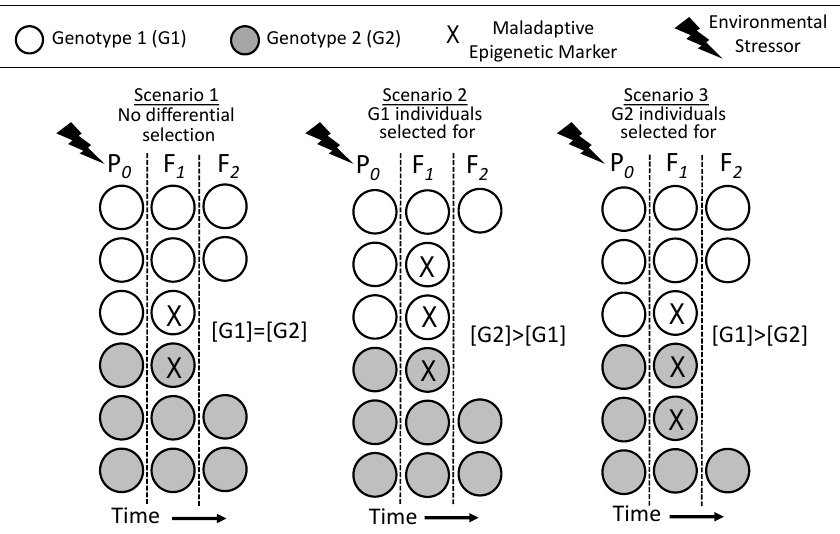
Figure 5. Changes in the distribution of genotype within a population as a result of differential selection against individuals with a maladaptive epigenetically-inherited phenotype (X) arising in the F 1 generation. An environmental stressor experienced by the P 0 generation induces maladaptive epigenetic markers in the F 1 generation, and the individuals with the maladaptive phenotype are selected against. Importantly, the distribution of epigenetic markers in the F 1 in Scenarios 2 and 3 is both variable and independent of genotype. See the text for an additional discussion.